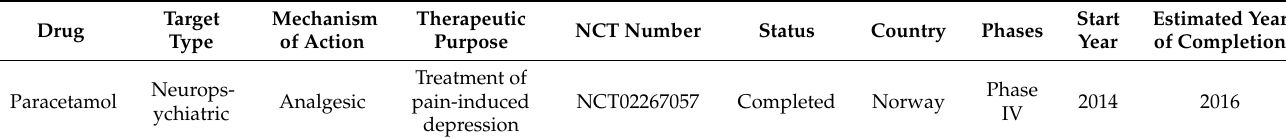
Table 3. Therapeutic agent for VCI and VaD treatment in phase IV testing.